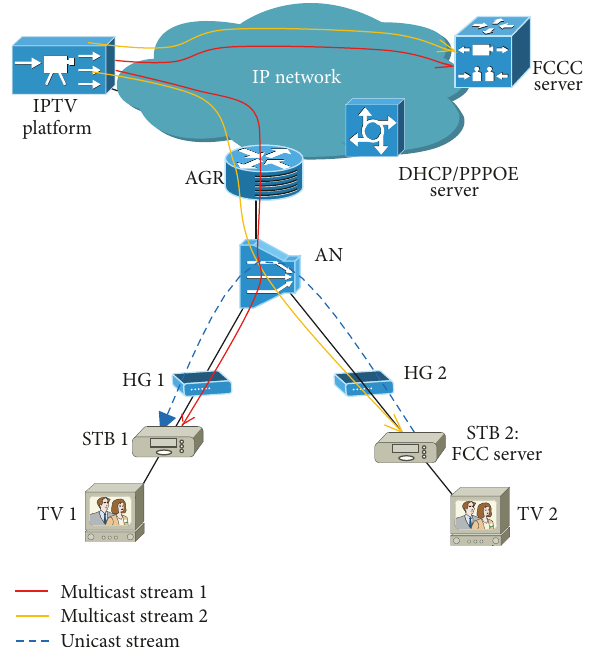
Figure 6: The proposed solution to reduce the FCC unicast